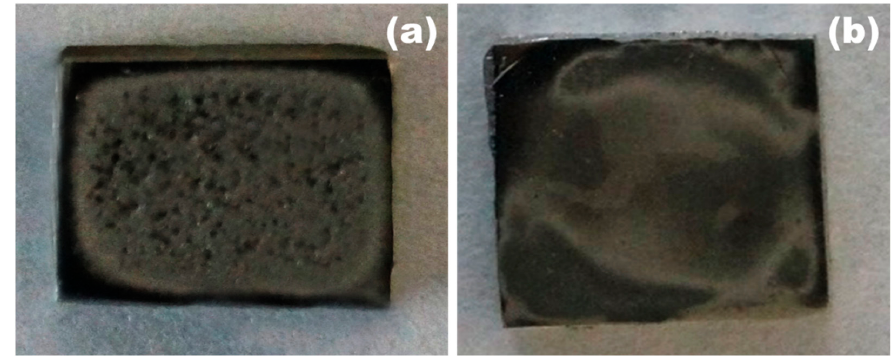
Figure 21. Macrographs showing the ( a ) SS316L steel and ( b ) Al 0.1 CrCoFeNi high entropy alloy (HEA) samples after cavitation erosion-corrosion testing for 20 h.